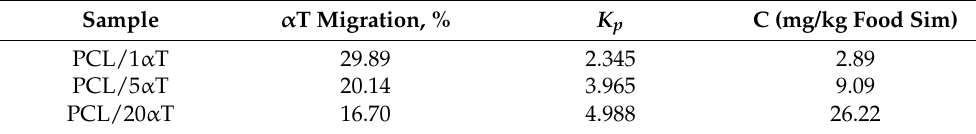
Table 1. Migration parameters of α -tocopherol from PCL/ α T electrospun fibers.